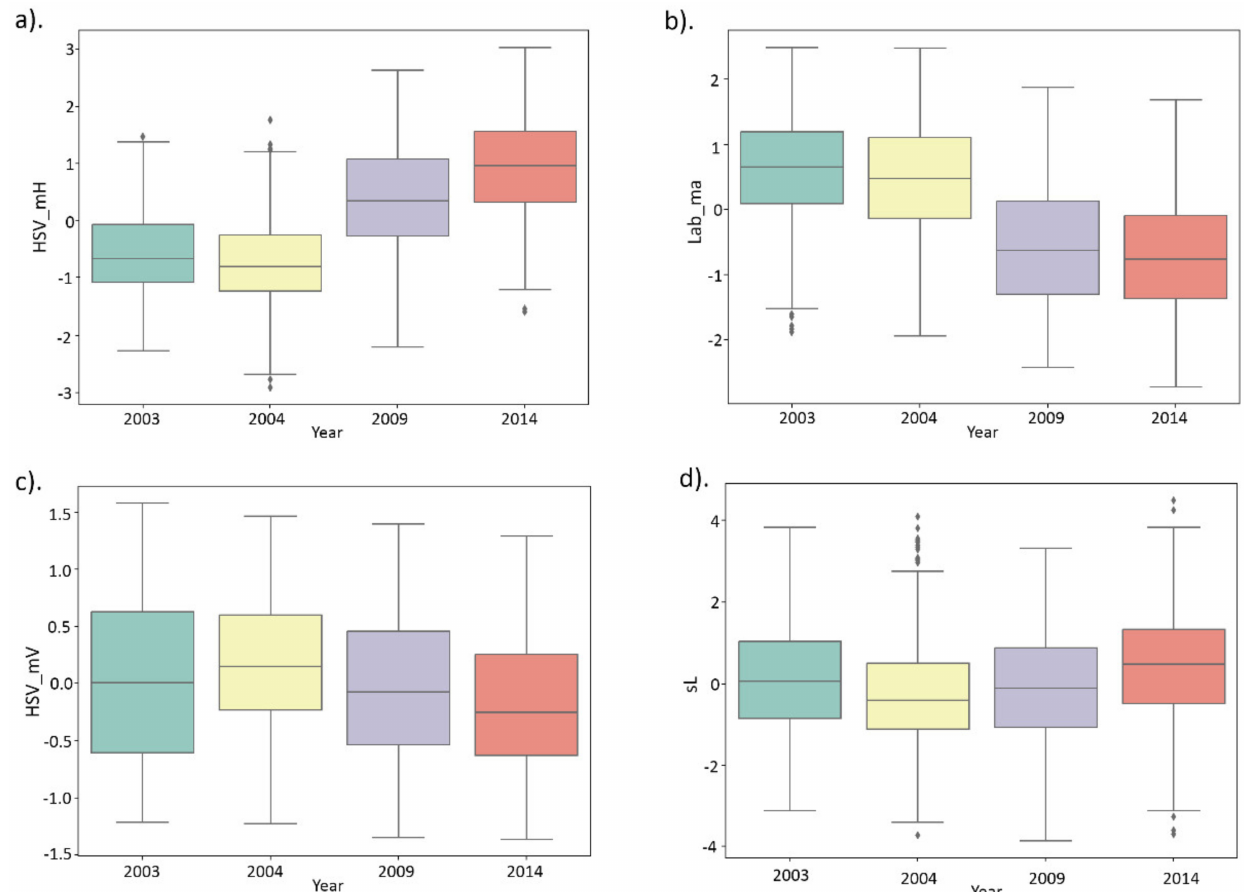
Figure 3. Bar plots for the distribution of the normalized HSV_mH ( a ), Lab_ma ( b ), HSV_mV ( c ) and sL ( d ) trait values ( Y axis) in the seed samples from different harvesting years ( X